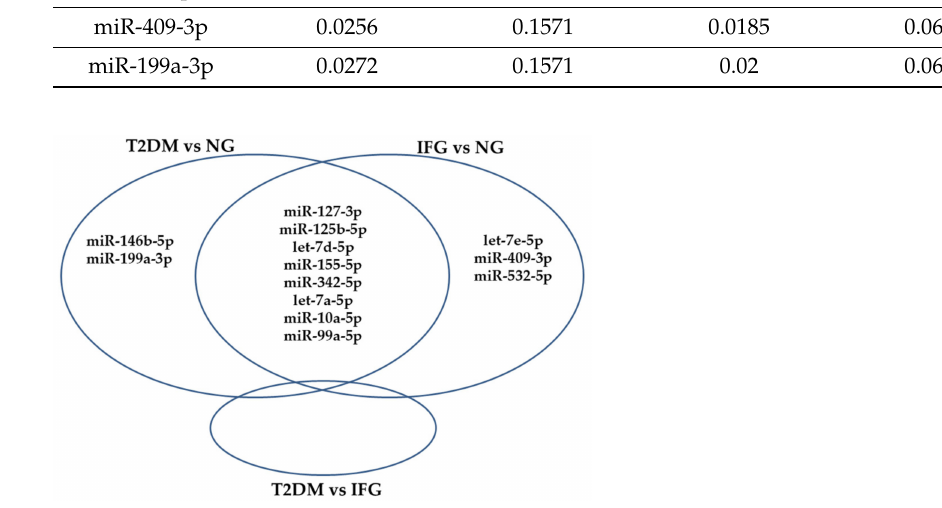
Figure 2. Venn diagram of significantly changed (upregulated) miRNAs (FDR < 0.2) between T2DM, IFG and NG subjects (N = 38) in VAT, based on one-way ANOVA and Tukey’s HSD post hoc test. ( p ≤